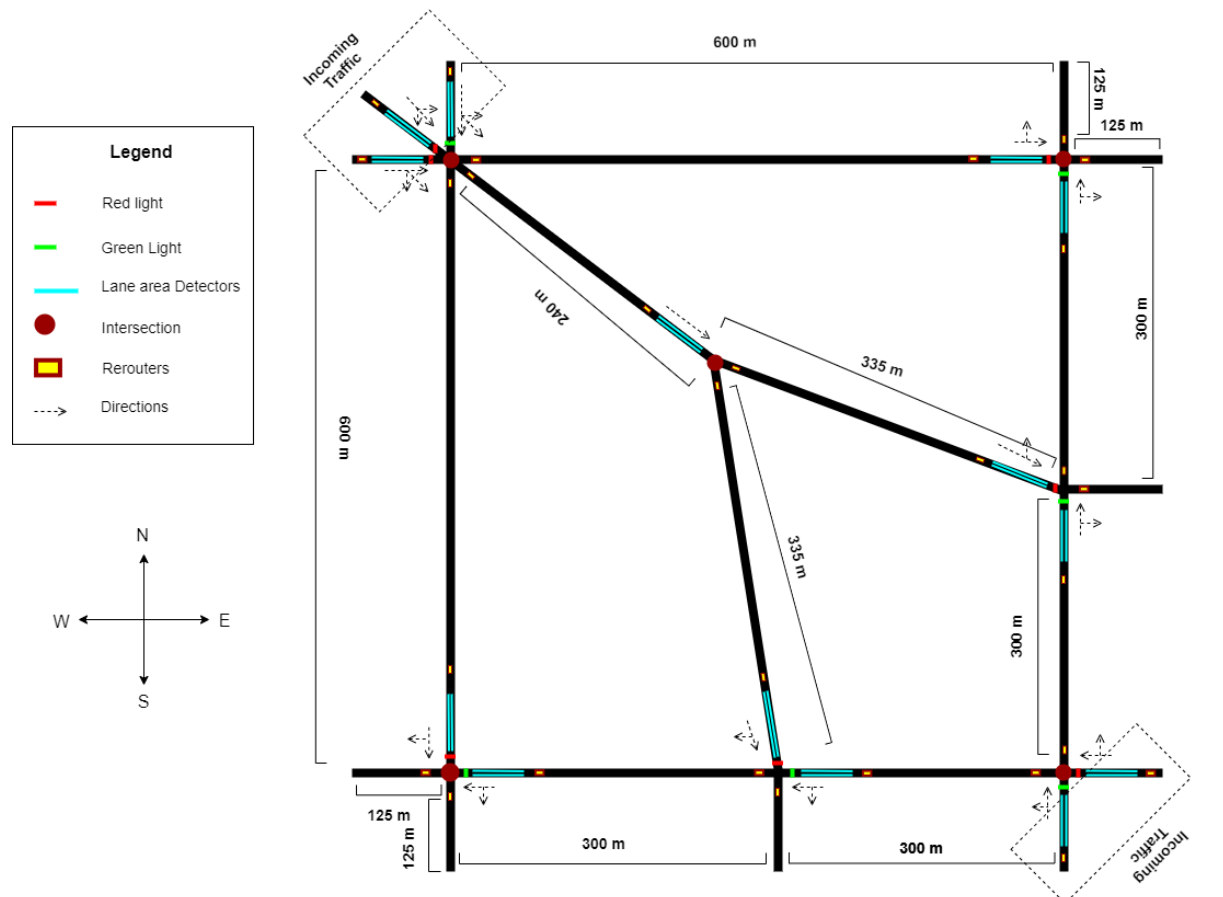
Figure 2. Road Network used for experiments with seven